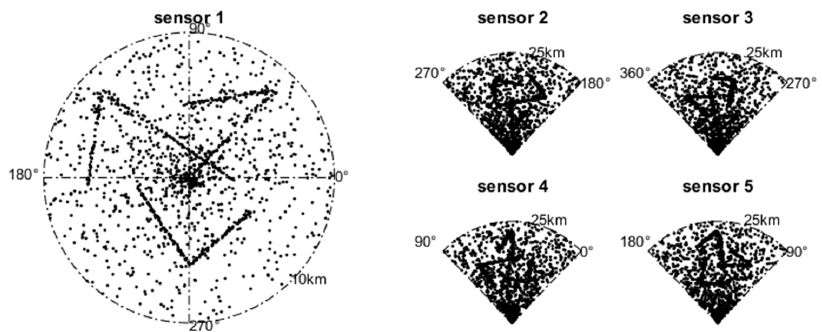
Figure 3. Measurement of the sensors.